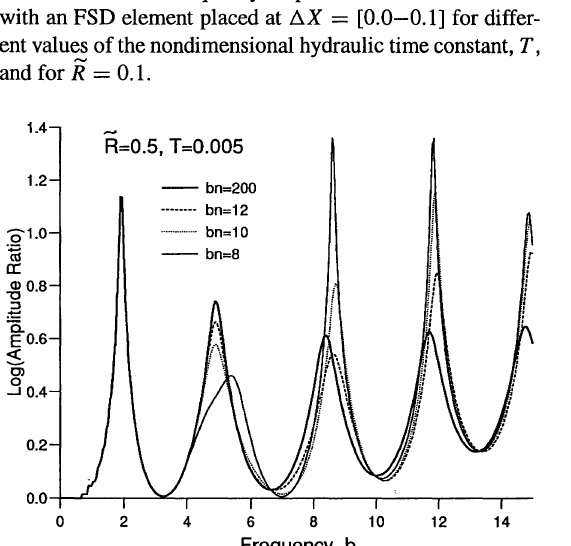
FIGURE 11 The frequency responses of the beam treated with an FSD element placed at AX = [0.0-0.1] and tuned to the first resonant